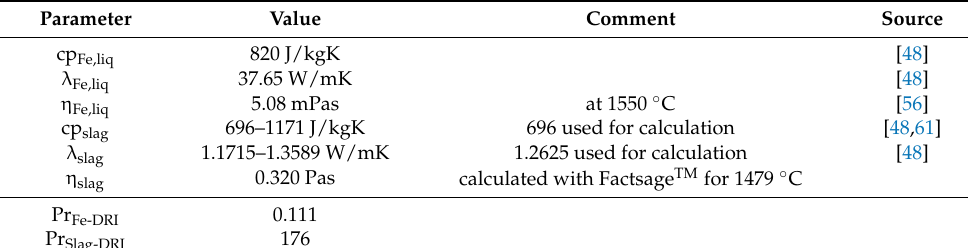
Table 9. Calculated dimensionless Prandtl numbers, incl. literature data for the